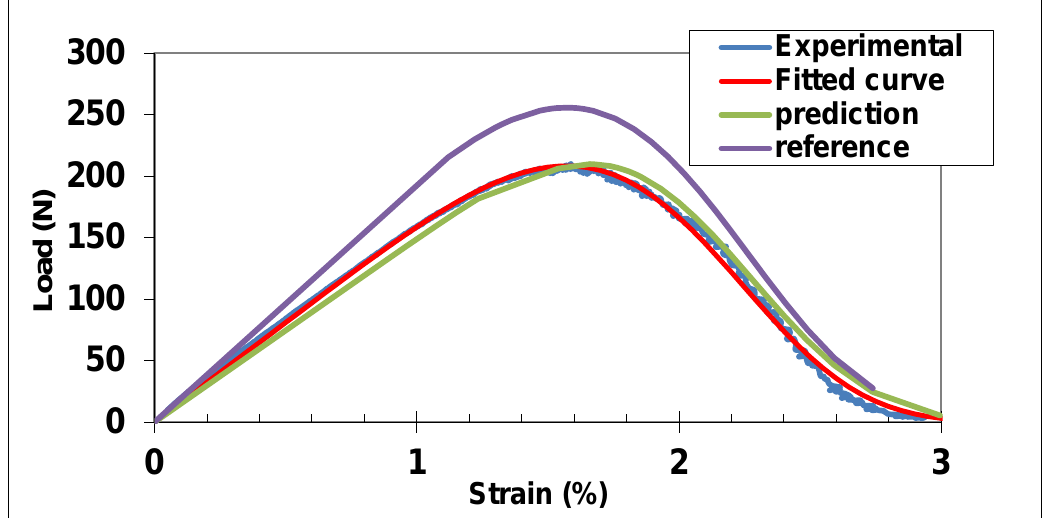
Figure 7. Tensile force-strain curves obtained for E-glass fibre tows: Experimental reference curve, experimental residual curve obtained on tow denoted test #4 in [15] subjected to static fatigue under constant deformation for 5.5 h in water, fitted residual curve for statistical parameters estimation and residual curve predicted for the slow crack growth parameters determined during test#4 ( n = 11.9, V* = 2.1 × 10 − 9 m/s).